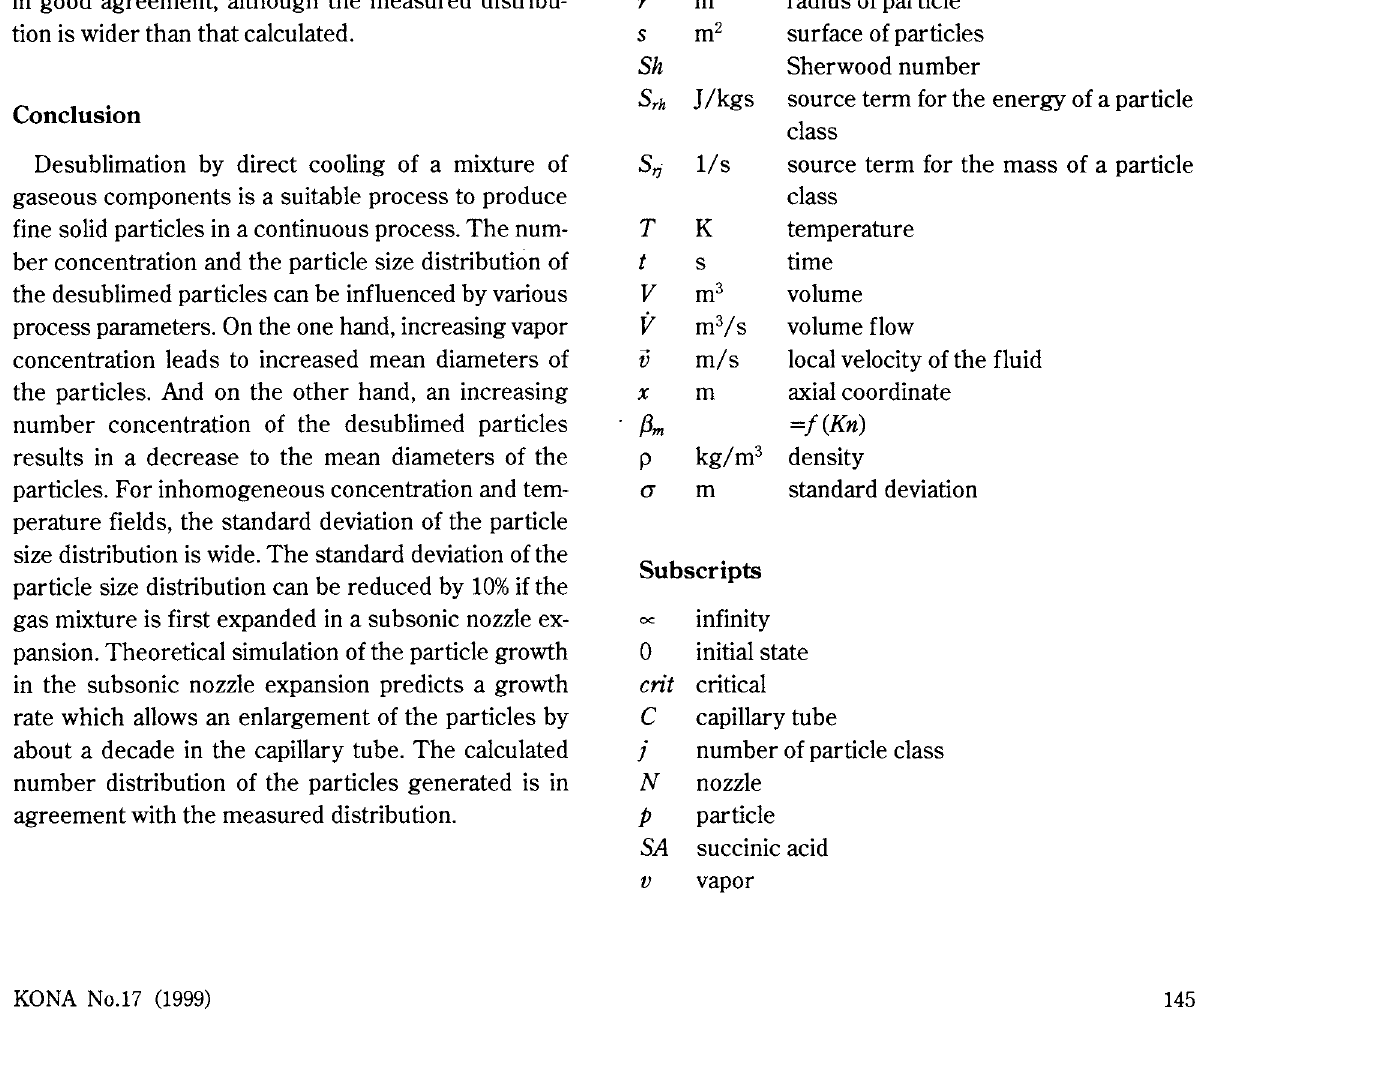
Fig. 10 Measured and calculated cumulative number distributions at the outlet of the mixing chamber of the mixing chamber in Fig. 10. For the calculation, it is presumed that the temperature of the particles equals the local gas temperature at any time. Homoge neous nucleation is neglected at any point of the flow field. The calculations are performed with 50 particle classes, which are shown by the dots in the diagram. The measured number distribution is shown by the continuous line. The mean particle diameter of the measured and calculated particle size distribution is in good agreement, although the measured distribu tion is wider than that